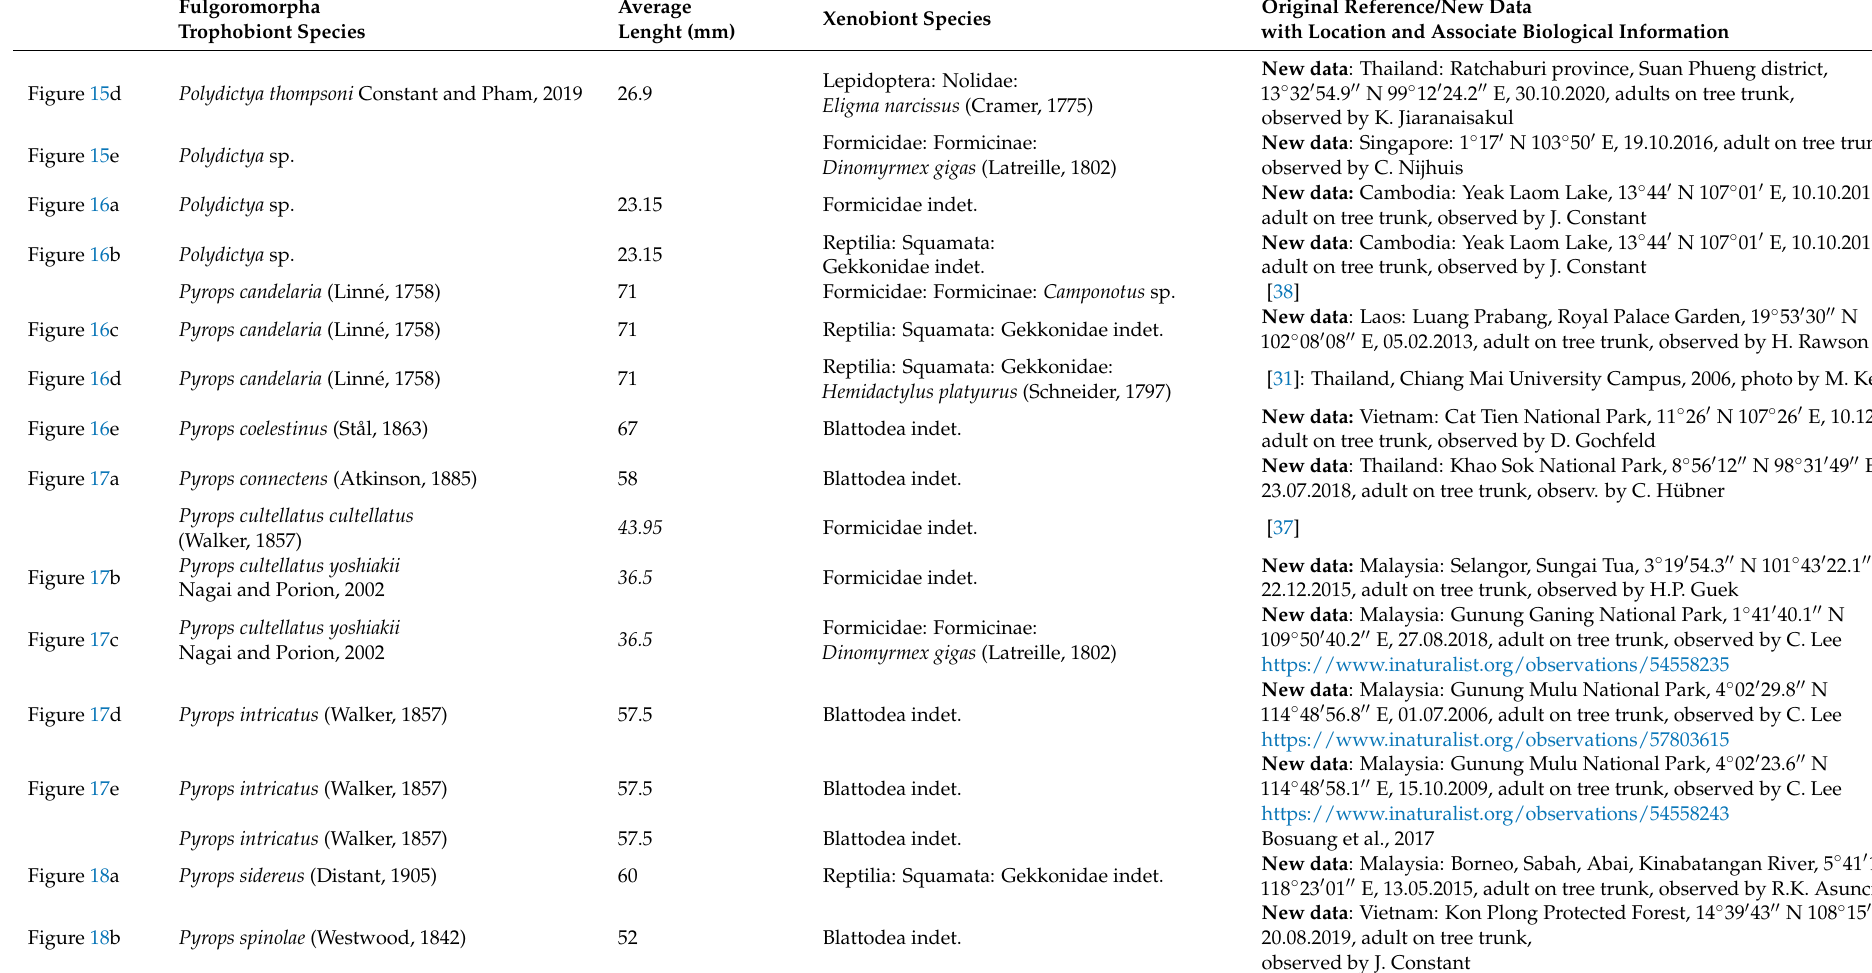
Figure 18a Pyrops sidereus (Distant, 1905) Pyrops spinolae (Westwood,